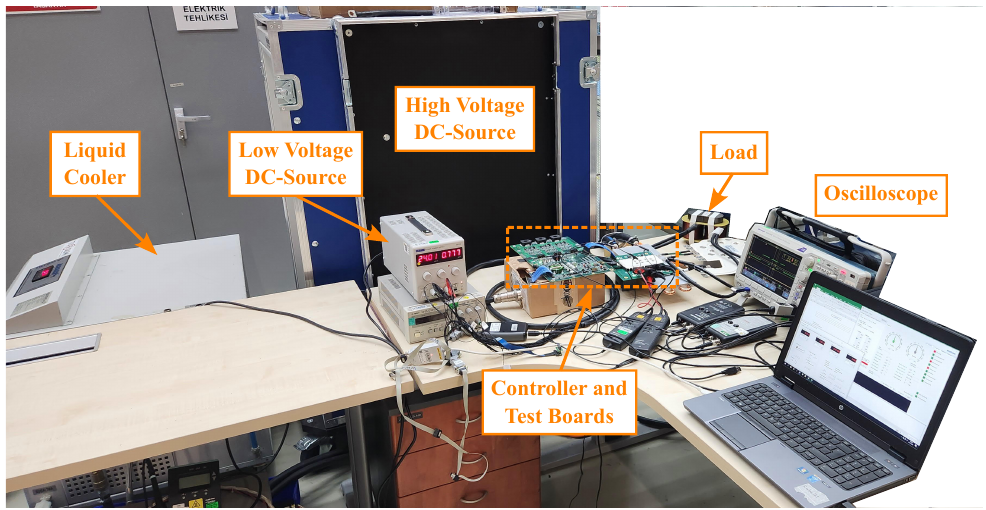
Figure 8. PCB images, ( a ) top side of the PCB, ( b ) bottom side of the PCB.